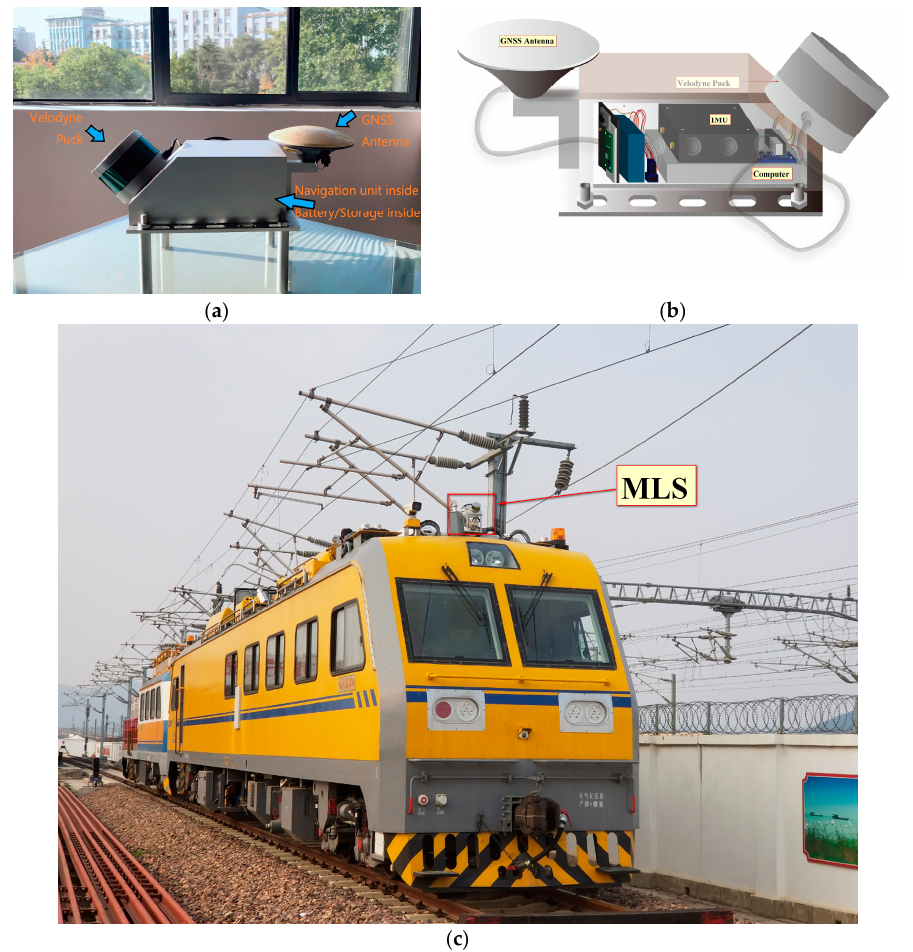
Figure 8. ( a ) Mobile laser system in this experiment; ( b ) Inside of the MLS system; ( c ) Experiment